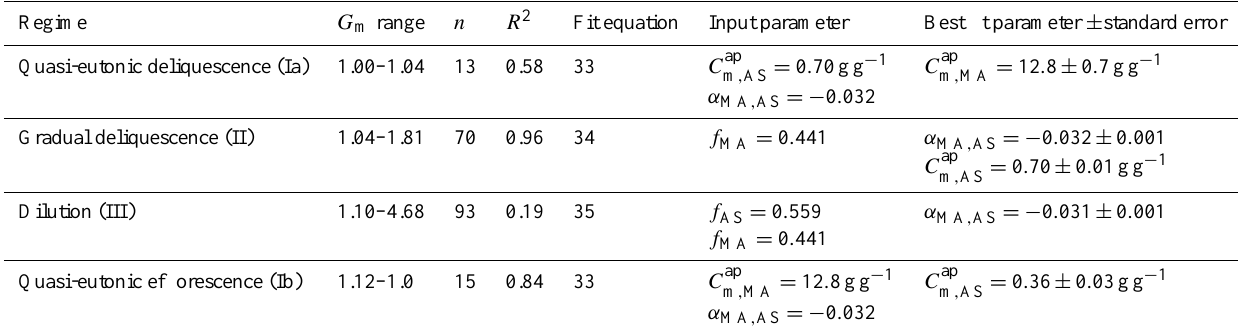
Table 4. KIM fit parameters for mixed malonic acid – ammonium sulfate particles (MA-AS, mole ratio 1 : 1). C ap apparent solubilities of ammonium sulfate and malonic acid in the specified hygroscopicity regimes, f AS and f MA are the mass fractions of ammonium sulfate and malonic acid in the dry particle material, and α MA , AS is the cross-interaction parameter. n and R 2 are the number of data points and the coefficient of determination of each fit over the relevant range of mass growth factor ( G m ) .